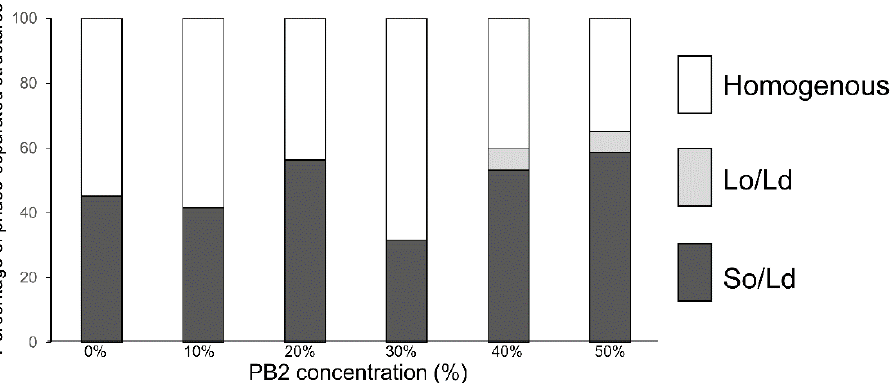
Figure 3. The percentage of phase-separated structures. 1,2-Dioleoyl-sn-glycero-3-phosphocholine (DOPC)/1,2-dipalmitoyl-sn-glycero-3-phosphocholine (DPPC) with various concentrations of procyanidin b2 (PB2) are shown. White, bright gray, and dark gray bars denote homogenous, liquid-ordered (Lo)/liquid-disordered (Ld), and solid-ordered (So)/Ld phases, respectively. Lipid compositions of the observed liposomes in the experiment were DOPC/DPPC/PB2 50:50:0, 45:45:10, 40:40:20, 35:35:30, 30:30:40, and 25:25:50. Based on previous studies, So/Ld phase separation liposomes, DOPC/DPPC 50:50 were used as a control [12,25,26].